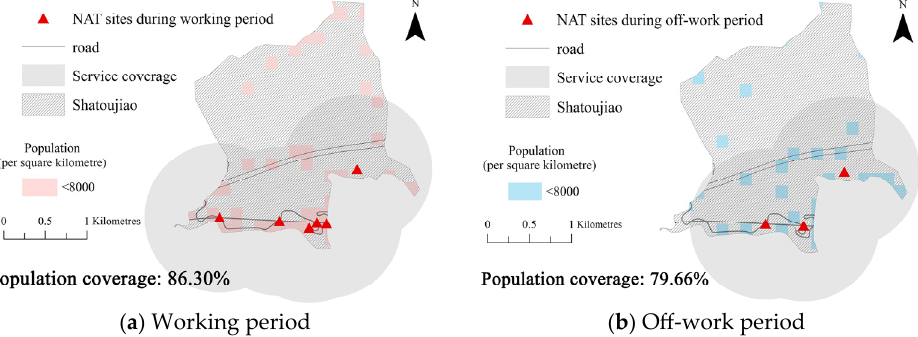
Figure 11. Service coverage of our NAT scheme in Shatoujiao subdistrict.